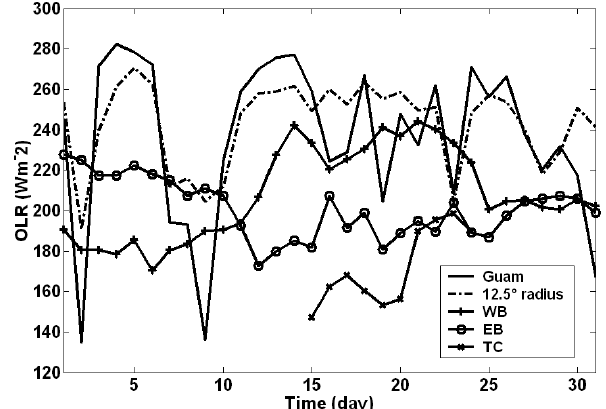
Fig. 12. Time series of NOAA Interpolated OLR data above (a) Guam island (2.5 ◦ radius), (b) in the vicinity (12.5 ◦ radius), (c) the west basin at longitudes between 110 ◦ E and 140 ◦ E and lat- itudes between 10 ◦ S and 10 ◦ N, (d) the east basin at longitudes between 155 ◦ E and 180 ◦ E and latitudes between 10 ◦ S and 10 ◦ N and (e) TC Faxai (10.5 ◦